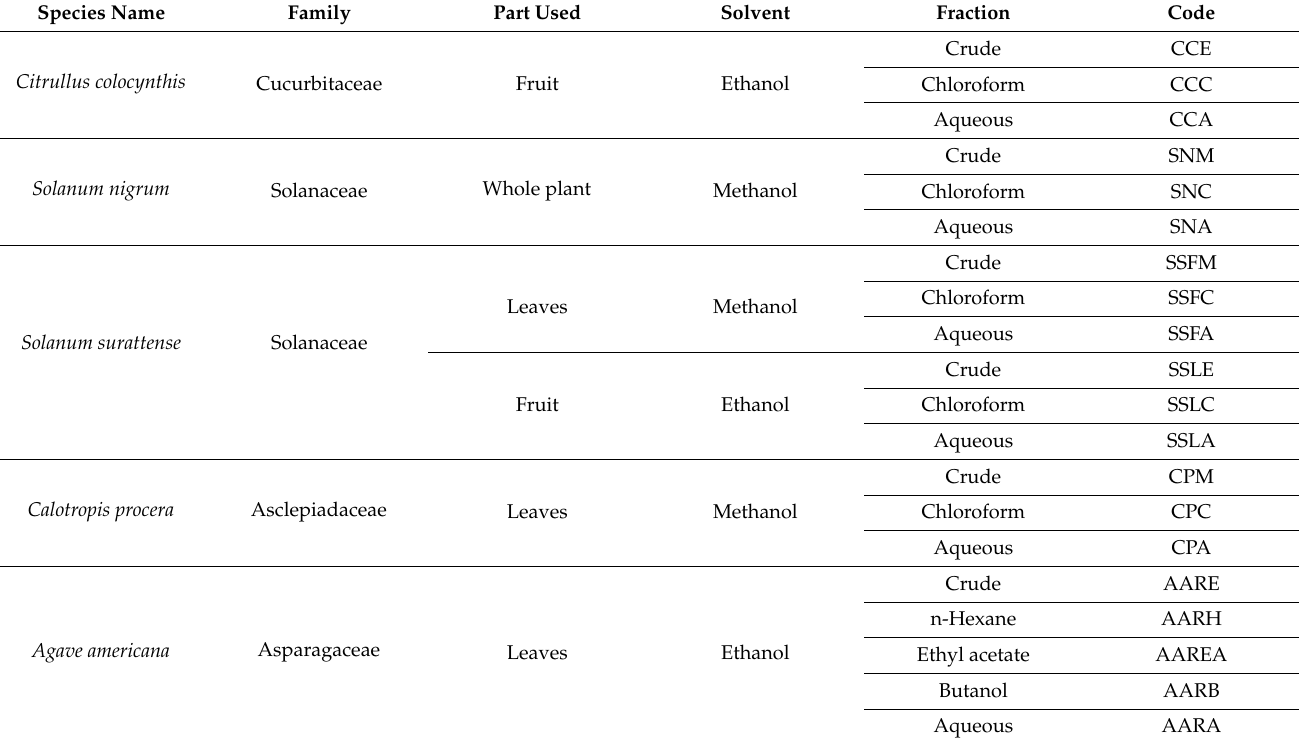
Table 1. Medicinal plants selected for the current